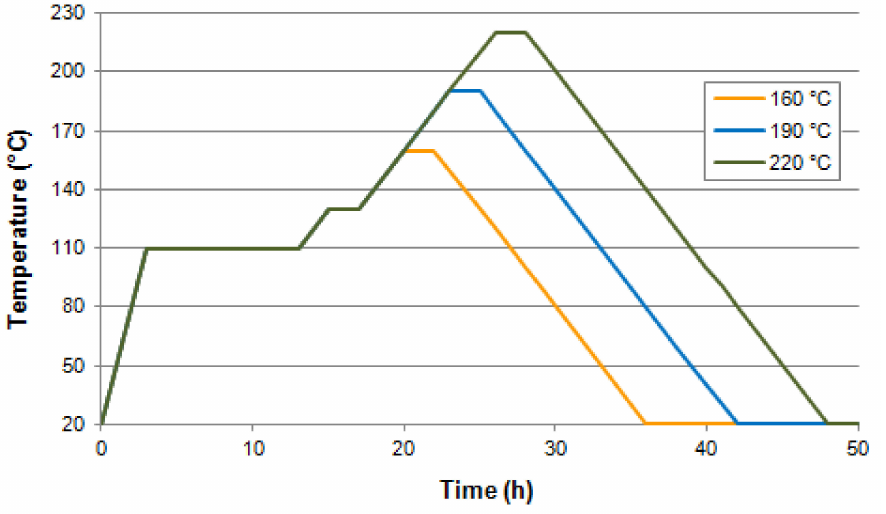
Figure 1. The course of thermal modification in nitrogen atmosphere of black poplar